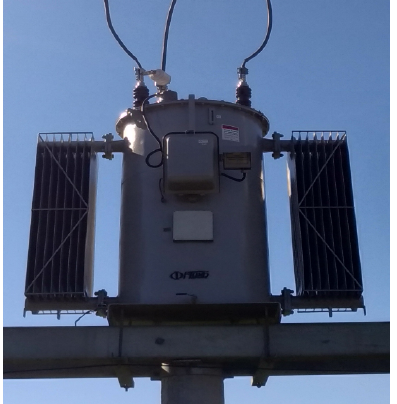
Figure 1. Toshiba Single-Phase Voltage Regulator operating in COOPERA’s network.